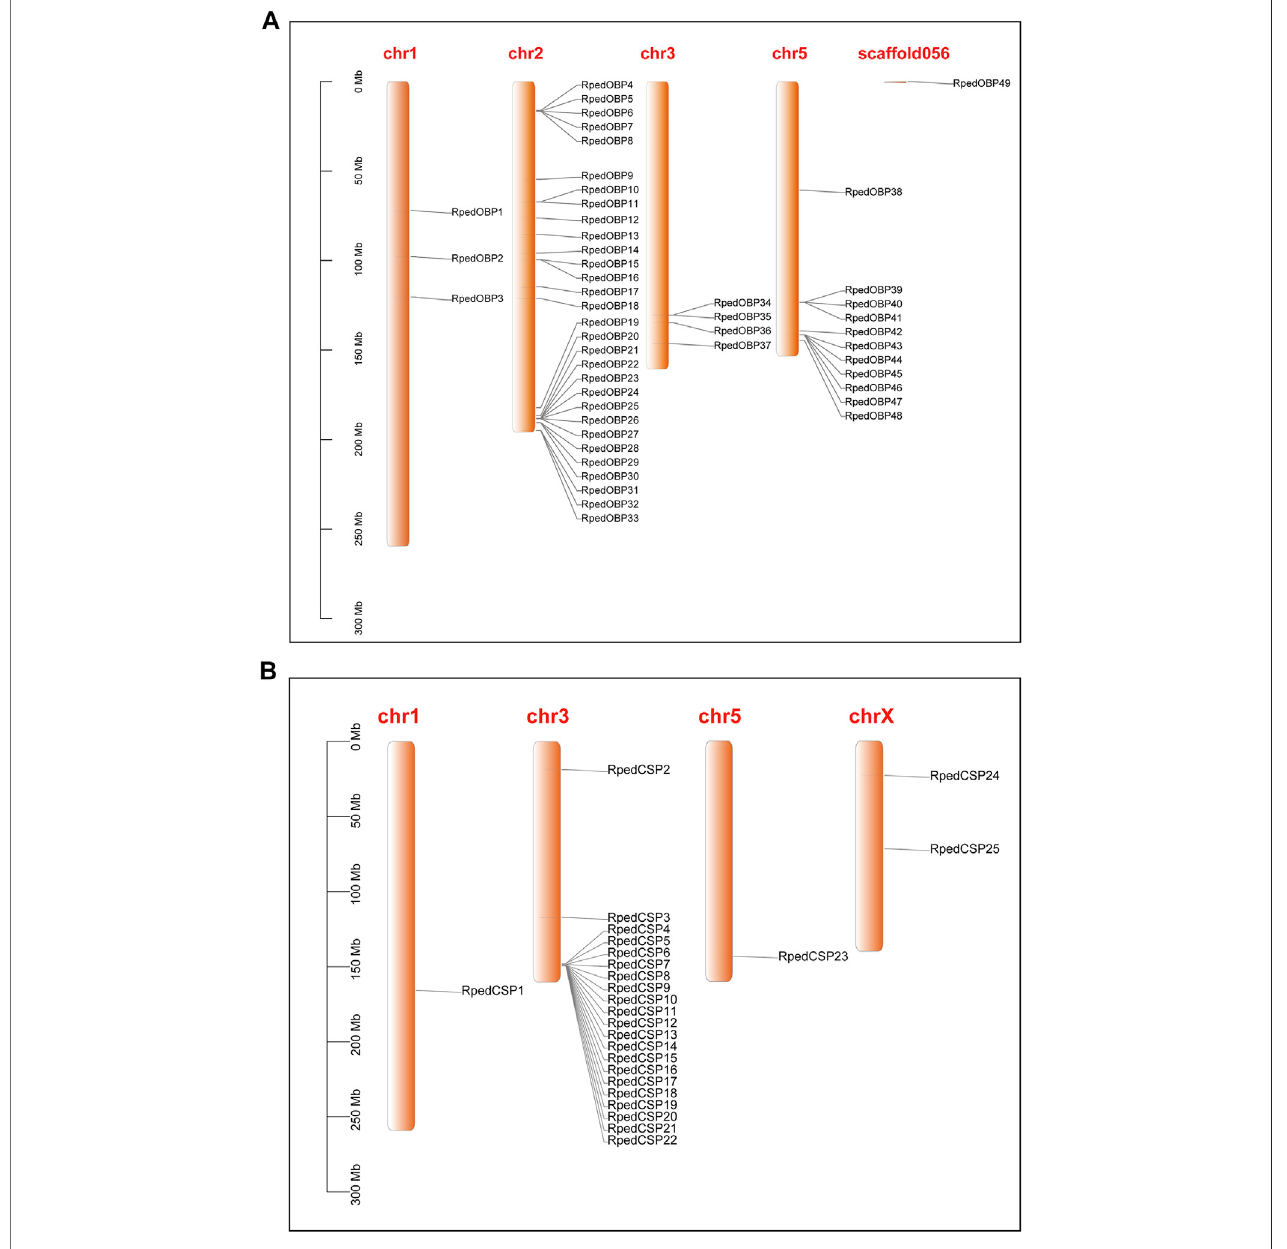
FIGURE2 | Localization ofOBPsand CSPs in the R.pedestris genome.Based on the annotation fi le of R.pedestris , weacquired the localization ofOBP and CSP genes in genome. (A) The RpedOBPs in the R. pedestris genome, they clustered together in 4 chromosomes and one scaffold. (B) The RpedCSPs in the R. pedestris genome, they clustered together in 4